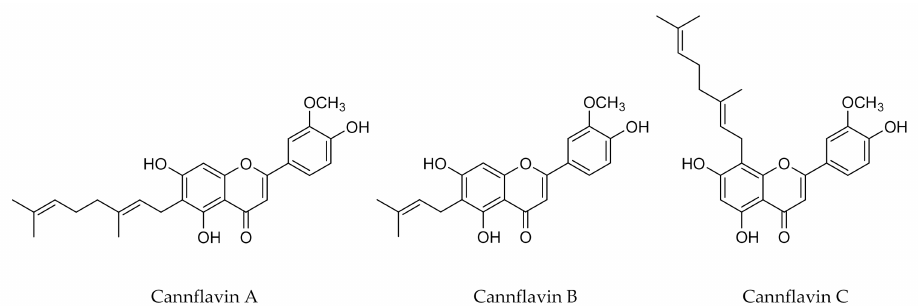
Figure 1. Specific flavonoids found in